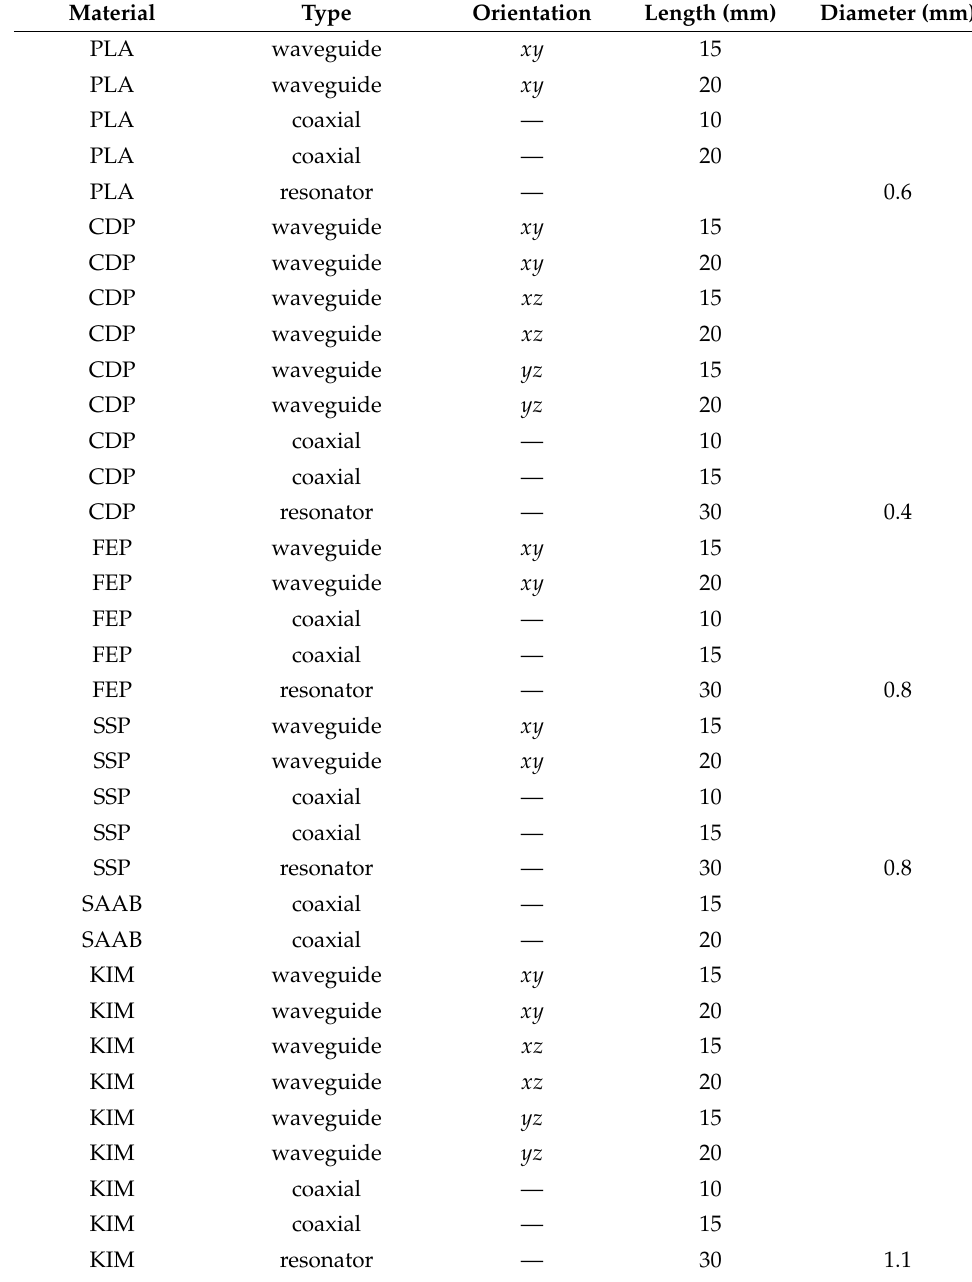
Table 3. Material samples that we have